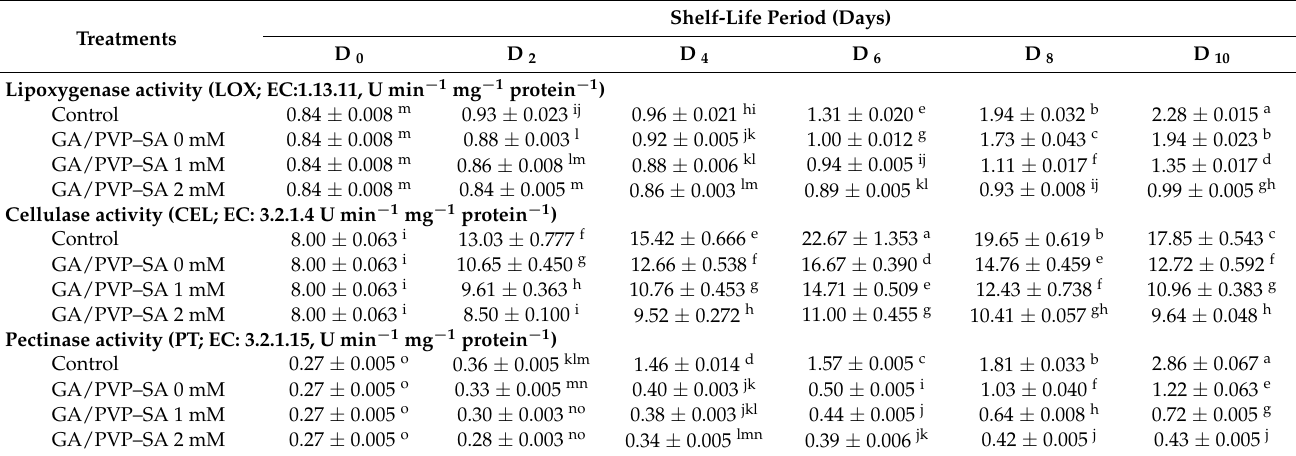
Table 3. Effect of different treatments of gum arabic (GA) and polyvinylpyrrolidone (PVP) blended with salicylic acid (SA) at different concentrations as a mixture biopolymer coating treatment (GA/PVP–SA) on cell-wall-degrading enzyme activities of peach fruit ‘Early Sweet’ during shelf life at ambient air (29 ± 1 ◦ C and air humidity 51%) during two seasons (2020 and 2021). Shelf-Life Period Treatments